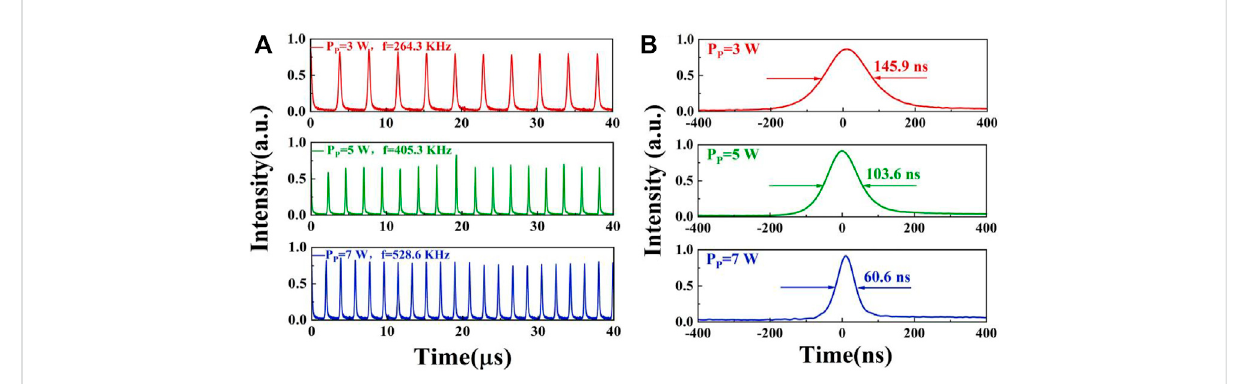
FIGURE 6 (A) Pulse sequence and (B) single pulse pro fi les of the passively Q-switched laser under the pump power of 3 W, 5 W, and 7 W.